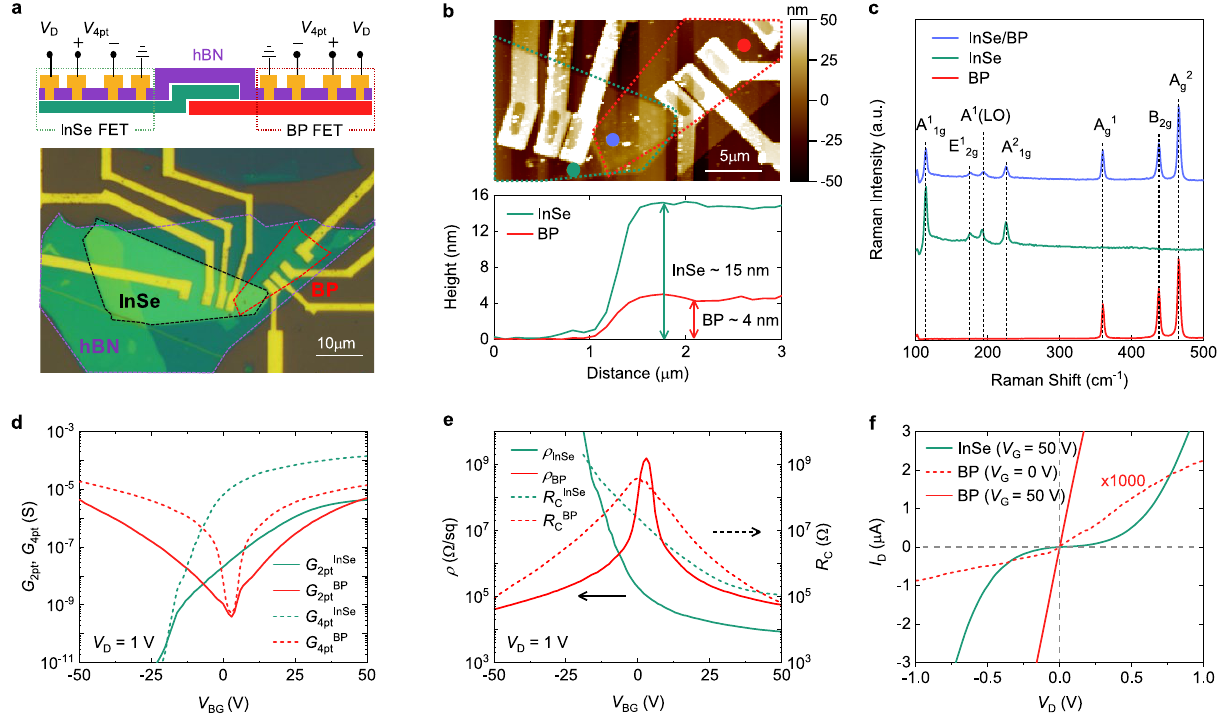
Figure 1. ( a ) Device schematic and optical micrograph of the InSe-BP-Ti device. The black, red, and purple dashed lines represent the InSe, BP, and hBN, respectively (lower micrograph). ( b ) Atomic force microscopic image of the device (upper) and the line profiles showing the thicknesses of the InSe and BP flakes (lower). ( c ) Raman spectra of the InSe/BP overlap region (blue), InSe region (green), and BP (red) region. ( d ) G 2pt InSe , G 2pt BP , G 4pt InSe , and G 4pt BP measured via the four-terminal methodology as a function of V BG at V D = 1 V. e) R C InSe , R C BP , ρ InSe , and ρ BP extracted from ( d ) data. ( f ) I D vs V D of the InSe at V BG = 50 V and that of the BP at V BG = 0 and 50 V, showing the Schottky behavior of the Au/Ti contacts on the InSe and the ohmic characteristic of the contacts on the